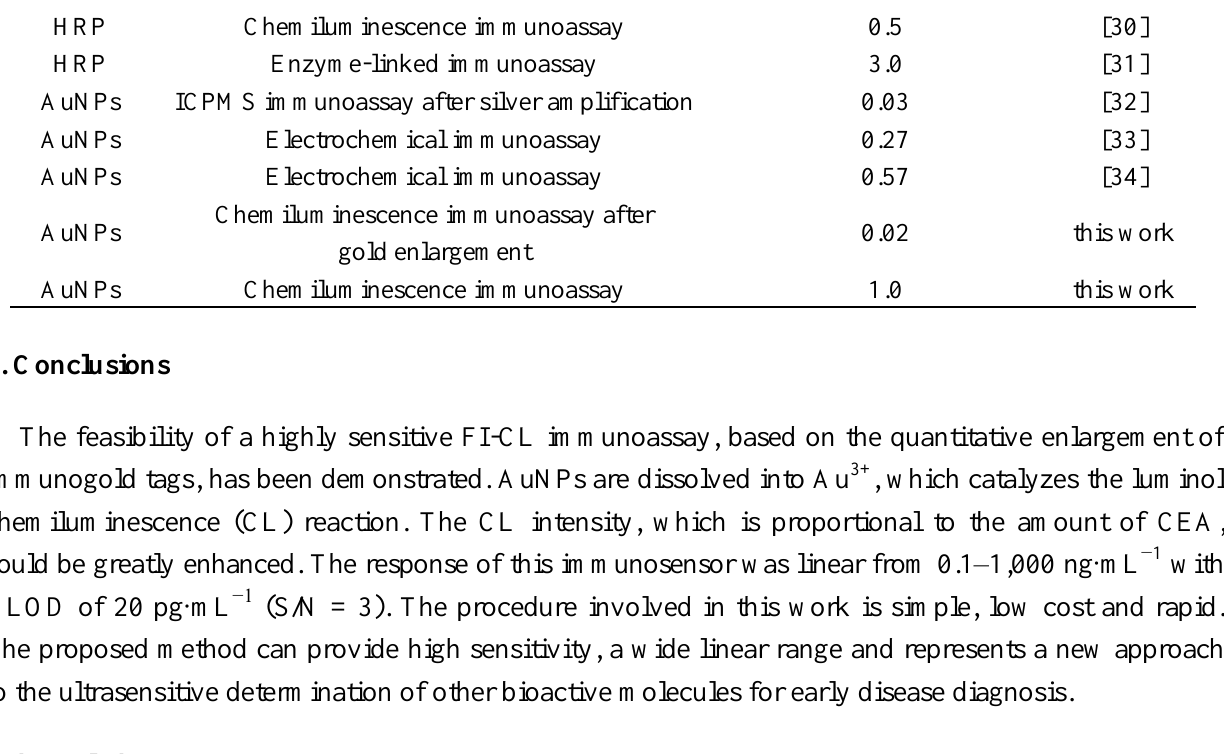
Table 1. Comparison of various immunoassay methods for CEA determination.